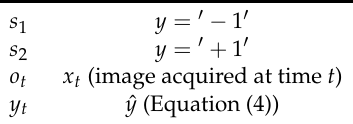
Table 1. HMM notations in accordance to our detection problem.